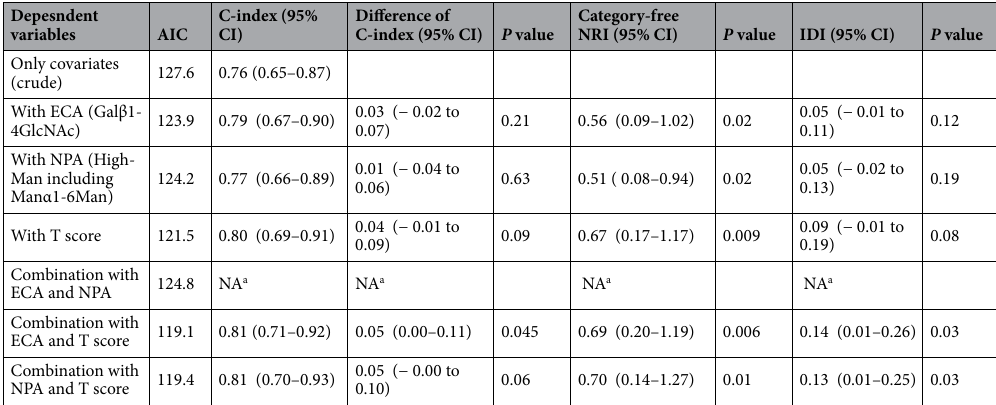
Table 6. AIC, category-free NRI, and IDI for predicting the 3-year outcome with glycan index data, and difference of C-index between estimation models with or without glycan index and T score. Covariates (crude) were age, sex, estimated glomerular filtration rate, and log-transformed urinary protein excretion at the time of renal biopsy. AIC, Akaike’s information criterion; NRI, net reclassification improvement; IDI, integrated discrimination improvement; 95% CI, 95% confidence interval; C-index, concordance index; T score, tubular atrophy and interstitial fibrosis (T0 ≤ 25%, 25% < T1 ≤ 50%, T2 > 50% of cortical area); ECA, Erythrina cristagalli lectin; NPA, Narcissus pseudonarcissus lectin; NA, Not applied. a In combination with ECA and NPA model, the AIC was higher than the single models of ECA, NPA, and T score, and other statistical analyses were not